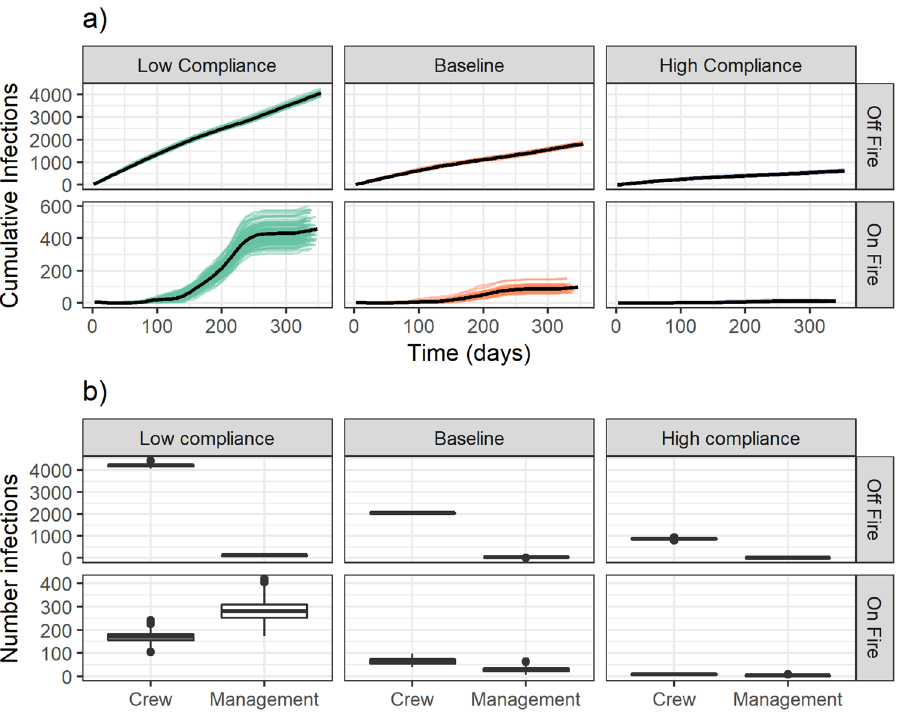
Figure 3. Daily cumulative infections by compliance scenario on and off fire ( a ) and annual cumulative infections by personnel type ( b ). In ( a ), each line is associated with a single scenario run while the bolded lines show a smoothed number of cumulative infections incurred. The total cumulative infections across the 2017 season by scenario and personnel role are shown in ( b ), with cases attributed to assignment status at time of